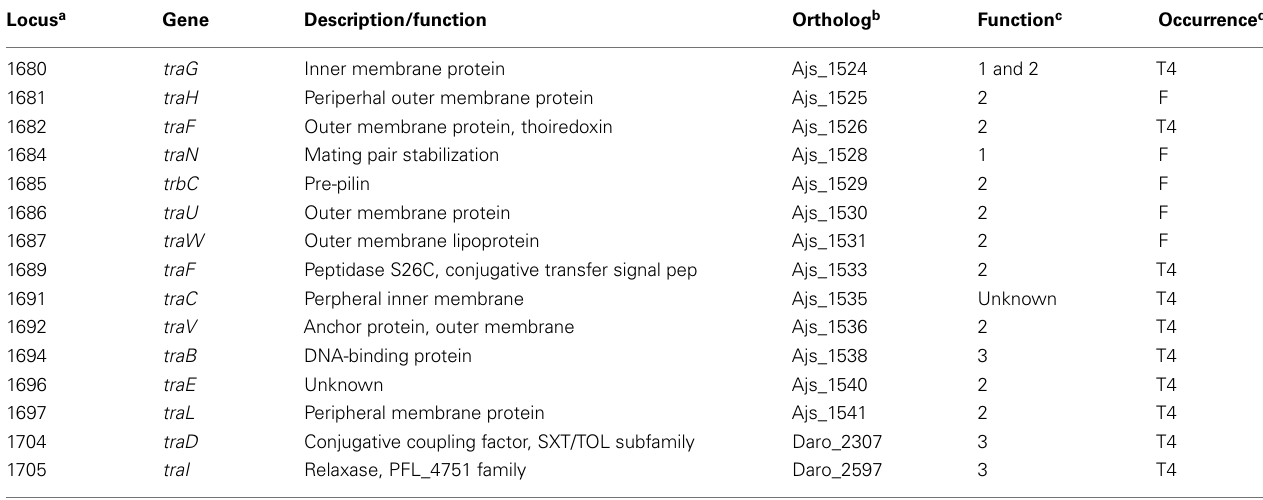
Table 4 |Type IV secretion system (T4SS) and F-specific transfersome